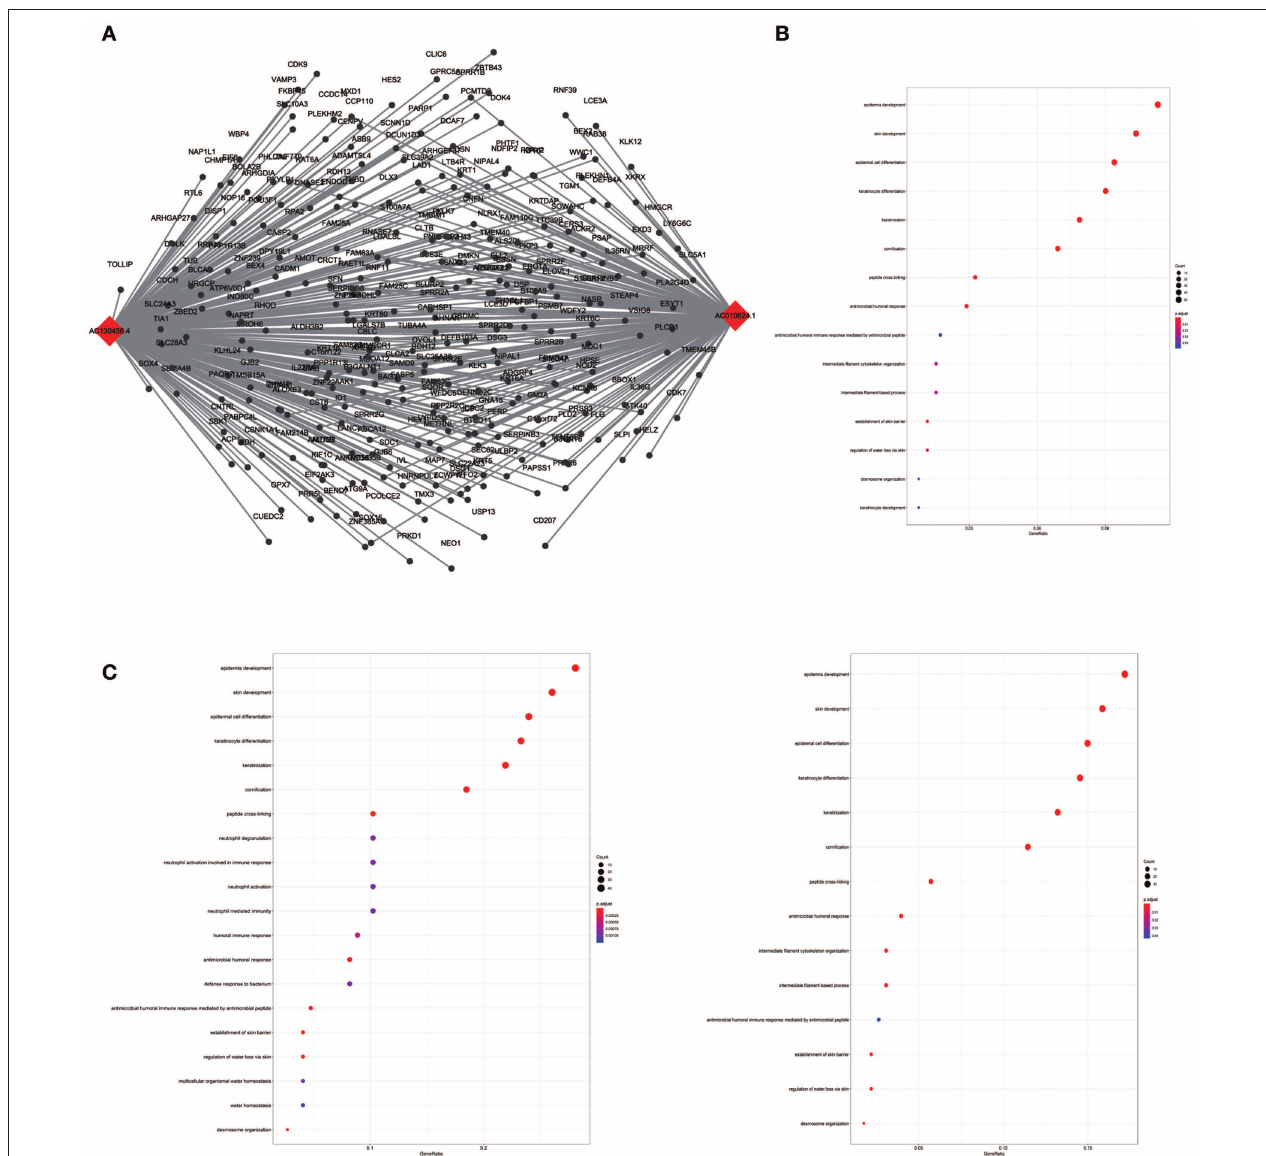
FIGURE 6 | LncRNA-mRNA network in Black module and functional enrichment. (A) The lncRNA-mRNA network in Black module, (B) GO-BP enrichment analysis (All genes in Black module), (C) GO-BP enrichment analysis (AC01 0624.1 related genes in Black module), and (D) GO-BP enrichment analysis (AC130456.4 related genes in Black